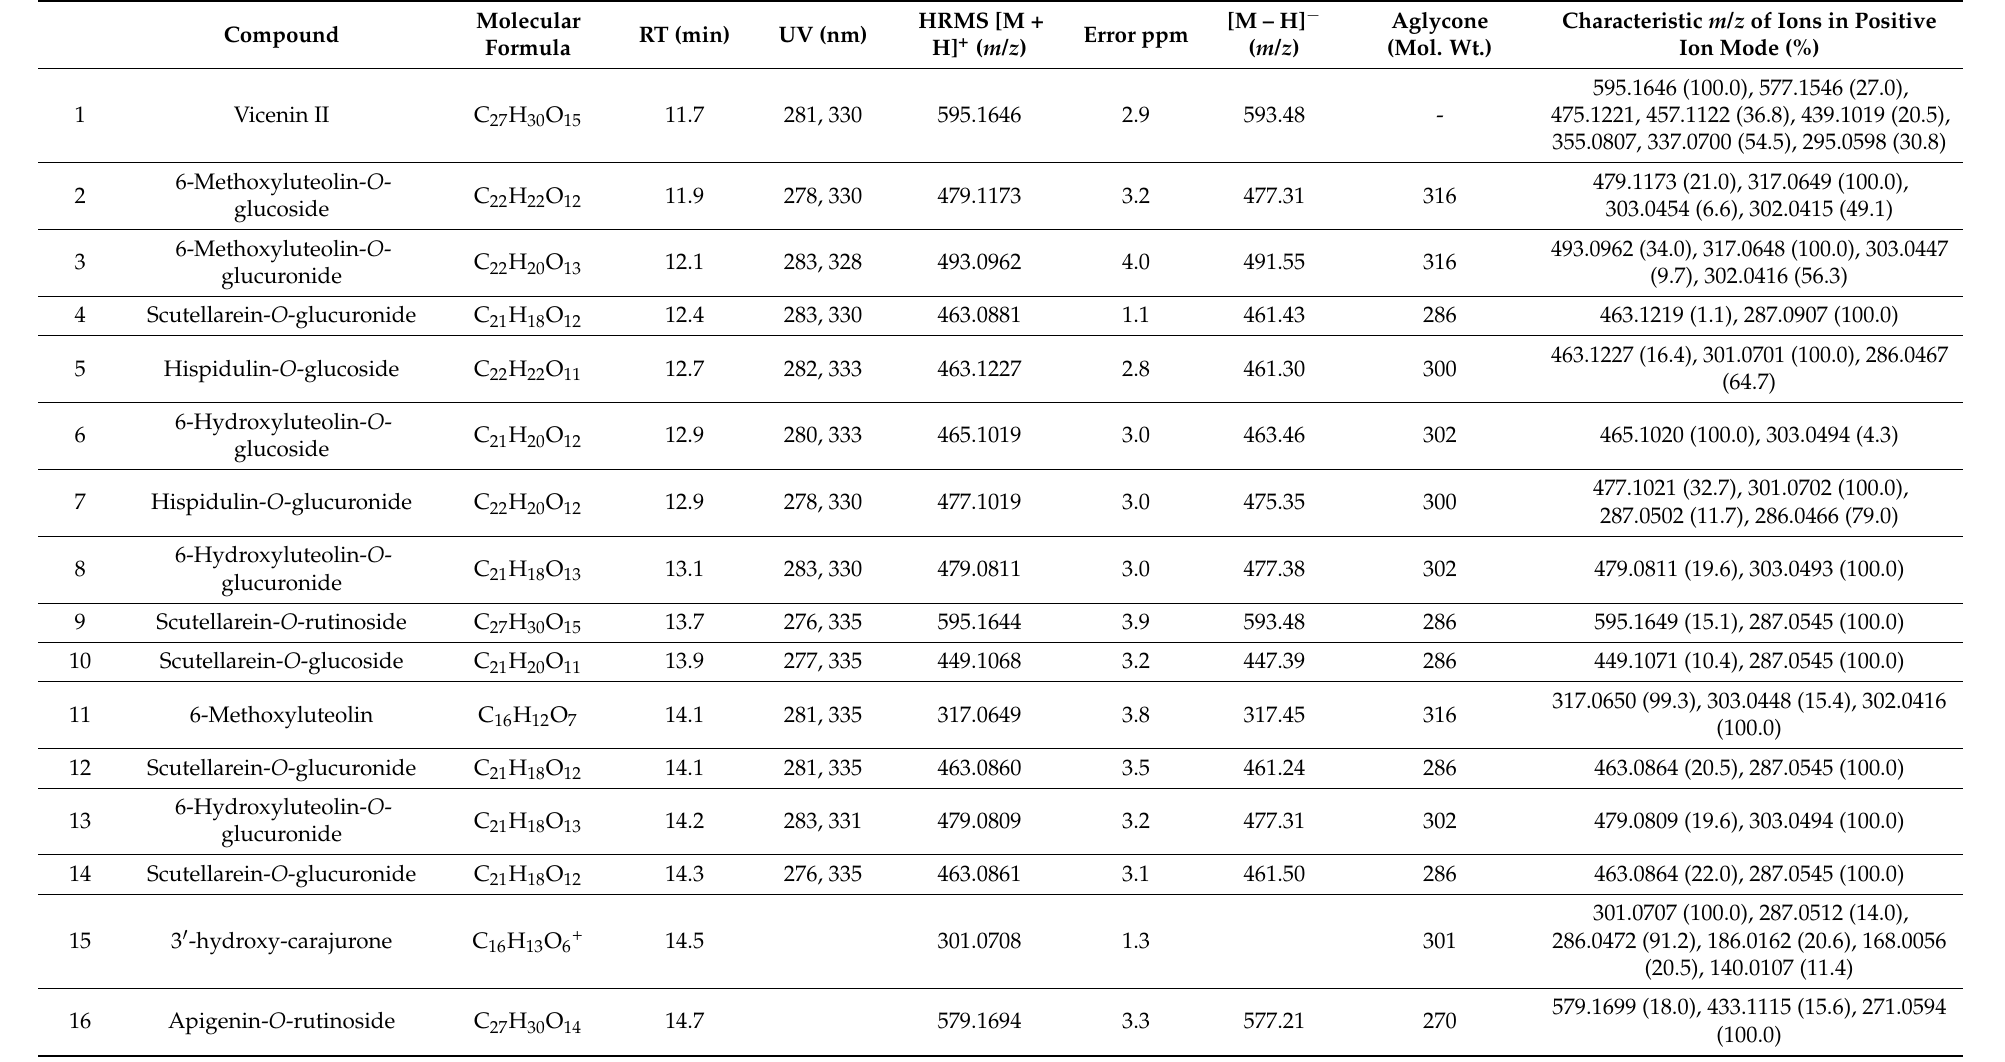
Table 1. Flavonoids partially identified in extract of Fridericia chica by